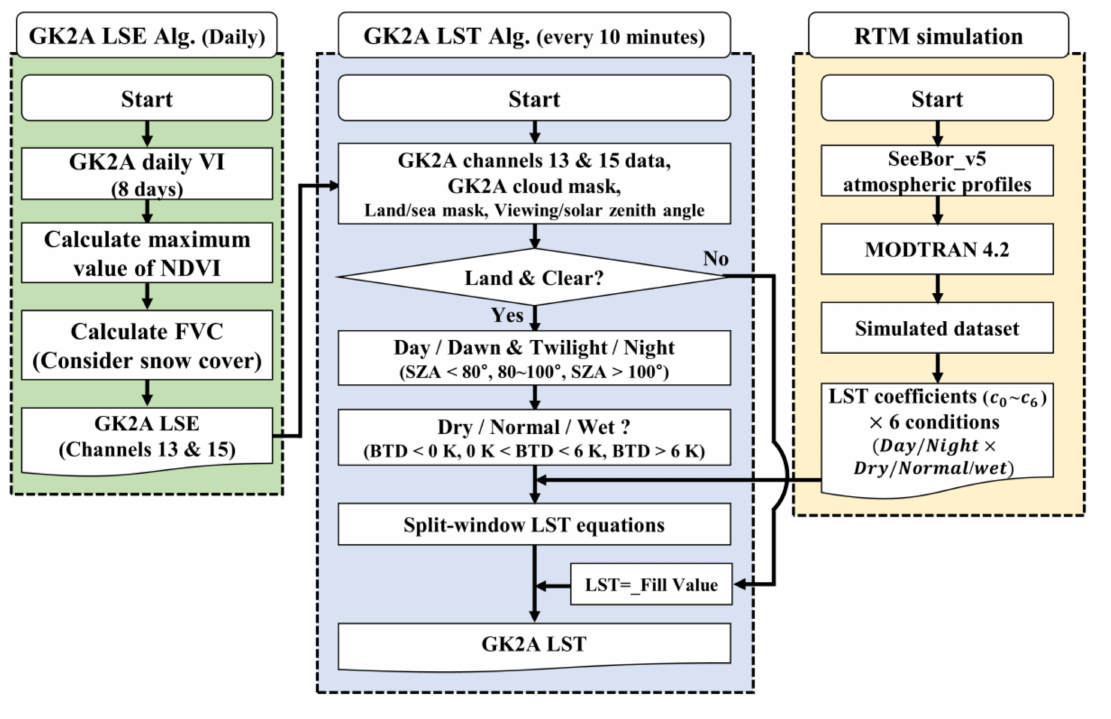
Figure 1. Flow chart of GK2A’s land surface temperature retrieval